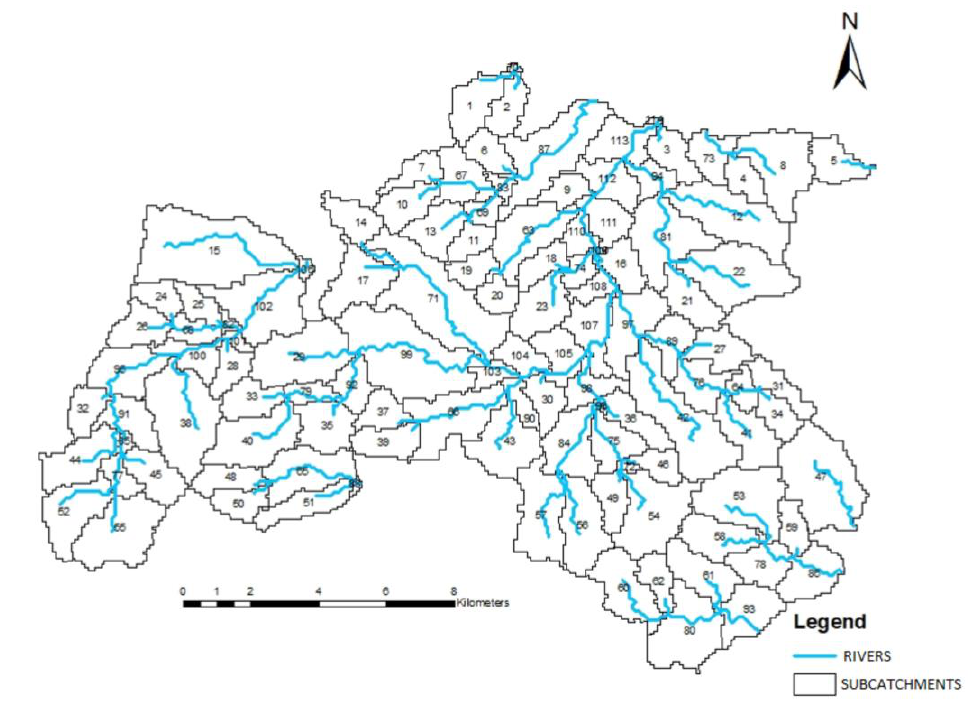
Fig. 9. The derived sub-catchments of the drainage line Table 3. List of curve number for urban catchments